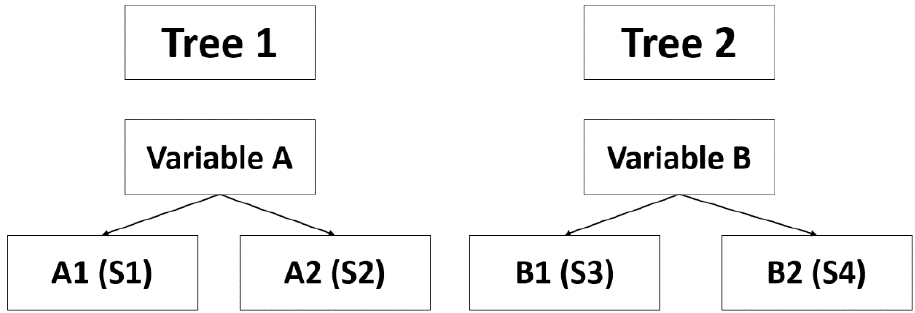
Figure 2. Classification and regression tree model (CART) sample. Two regression trees 1 and 2, split based on values of variable A and variable B, respectively. A1, A2, B1, and B2 are the leave names and S1, S2, S3, and S4 are the corresponding classification